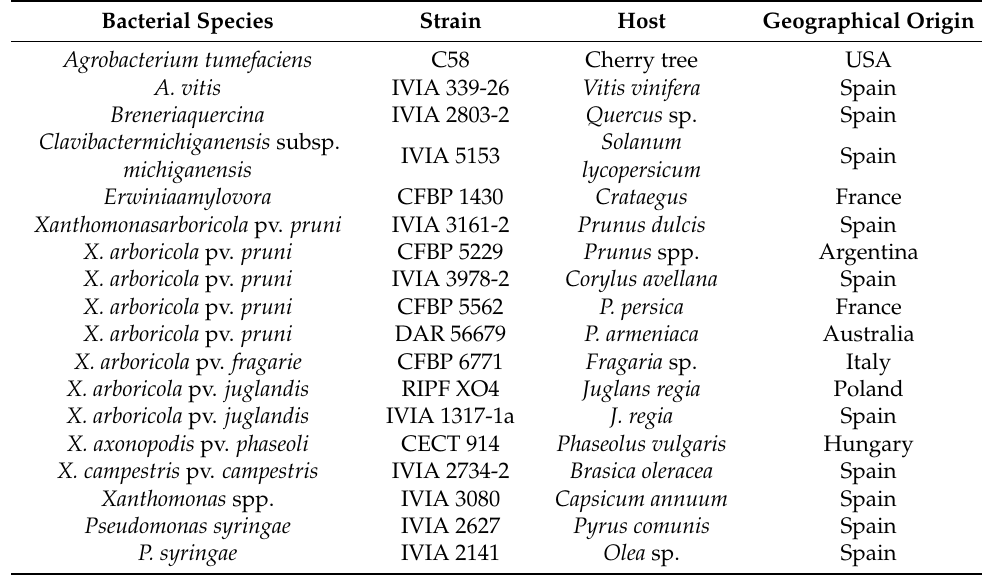
Table 2. Bacterial strains belonging to different genera and species present in plant hosts tested for specificity with monoclonal antibody